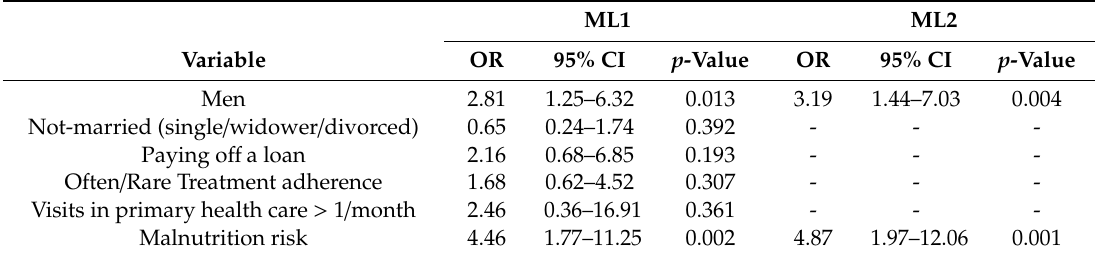
Table 2. Assessment of food-secure ( n = 60) versus food-insecure ( n = 61)